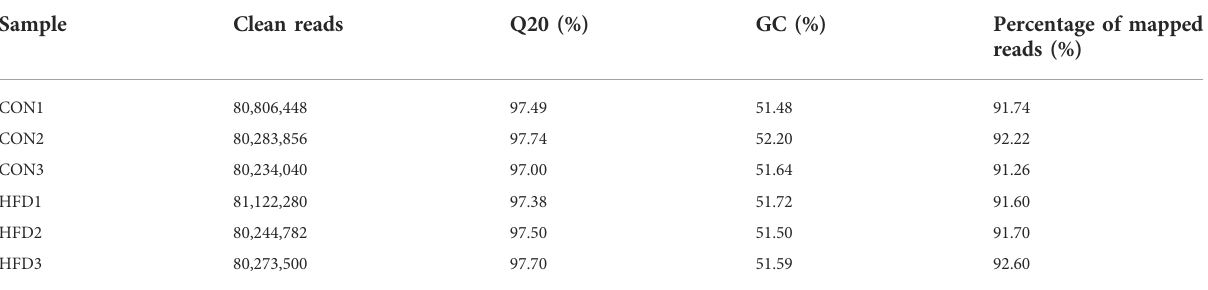
TABLE 3 Statistics of lncRNA data output quality of CON and HFD rabbits. Sample